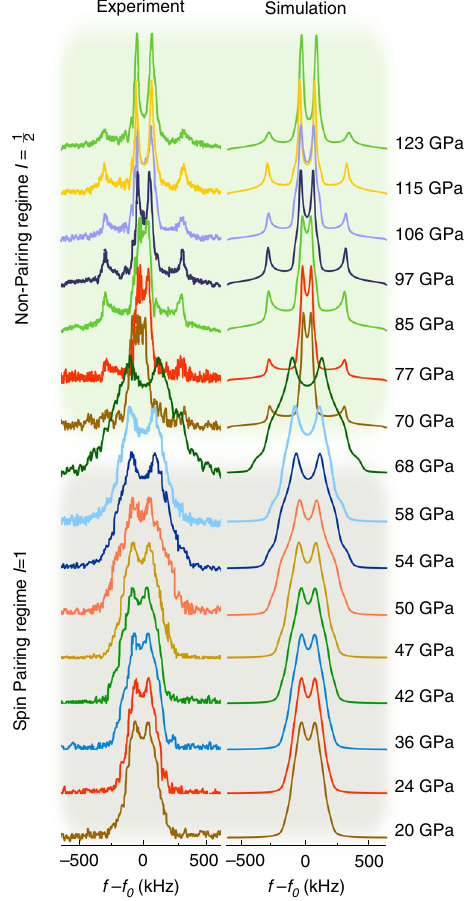
Fig. 2 Experimental and calculated 1H-NMR spectra of molecular H2 up to 123 GPa at room temperature. Between 20 and 68 GPa, fi rst-order quadrupole interactions describe the experimental data reasonably well. At P > 68 GPa, spectra were found to be broadened by dipole – dipole interaction resulting in a superposition of two Pake doublets corresponding to nearest and next-nearest hydrogen